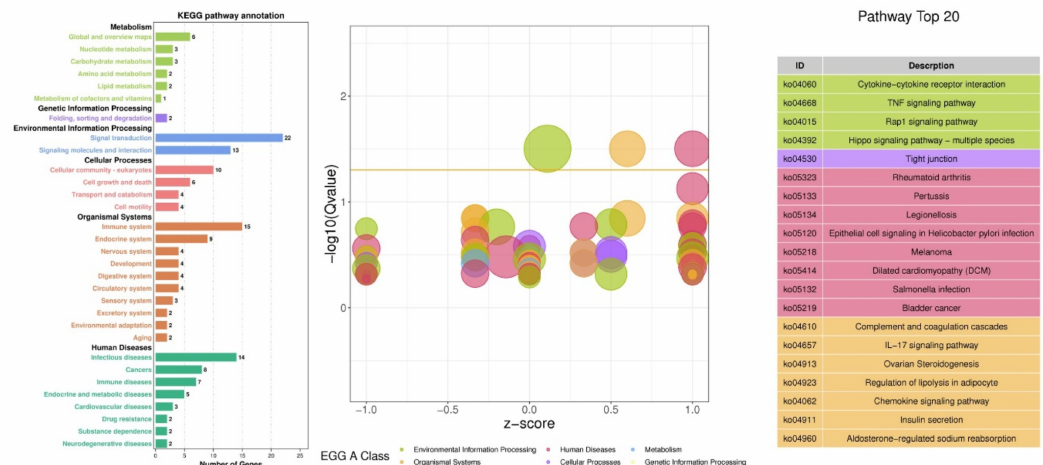
Figure 7. The KEGG pathway analysis of DEGs in 2 groups of bovine adipocytes transfected with bta-miR-149-5p (n = 3) mimics and mimics NC (n = 3). The KO enrichment difference bubble chart: the ordinate is -log10 (Qvalue), the abscissa is the z-score value (the difference between the number of upregulated genes and the number of downregulated genes accounts for the proportion of the total differential genes), and the yellow line represents Qvalue = 0.05 threshold. On the right is the list of pathways with the top 20 Q values. Different colors represent different A